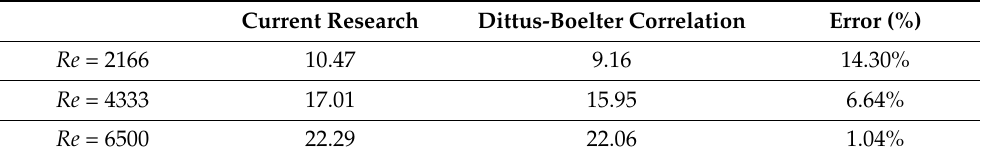
Table 1. Comparison of the Nusselt numbers that resulted from the current research with those of the Dittus-Boelter correlation